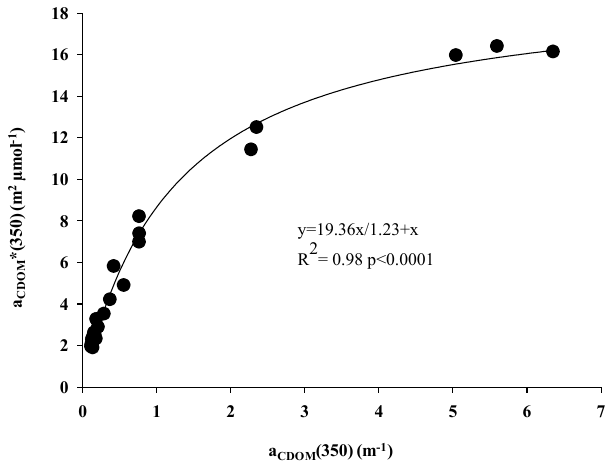
Fig. 5. Relationship between specific absorption coefficient at Figure 5. Relationship between s pecific absorption coefficient at 350 nm ( a CDOM *(350) ) and 752 350nm ( a CDOM *(350)) and a CDOM (350) in the Mackenzie Delta and North West sectors. a CDOM ( 350) in the Mackenzie delta and North west sectors 753